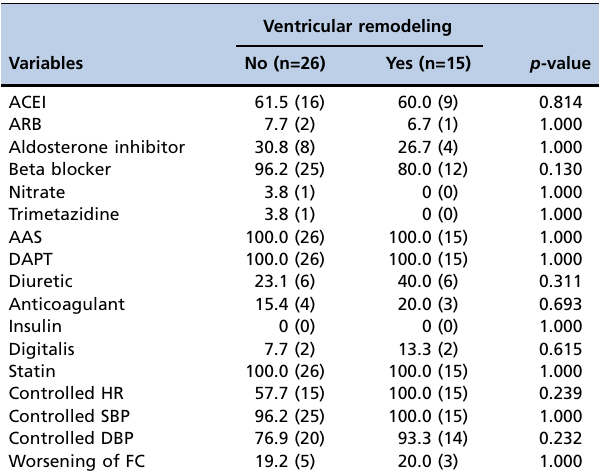
Table 3 - Medications at hospital discharge and clinical criteria of re-evaluation according to ventricular remodeling.